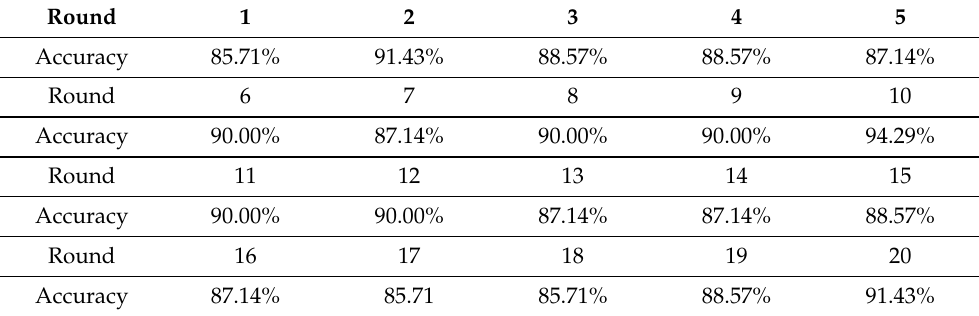
Table 4. Prediction results of 20 rounds of ∆